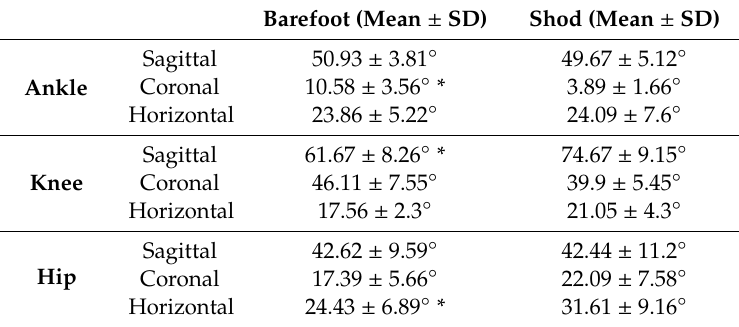
Table 3. Lower extremity joints’ range of motion (ROM) between barefoot and shod running in gait